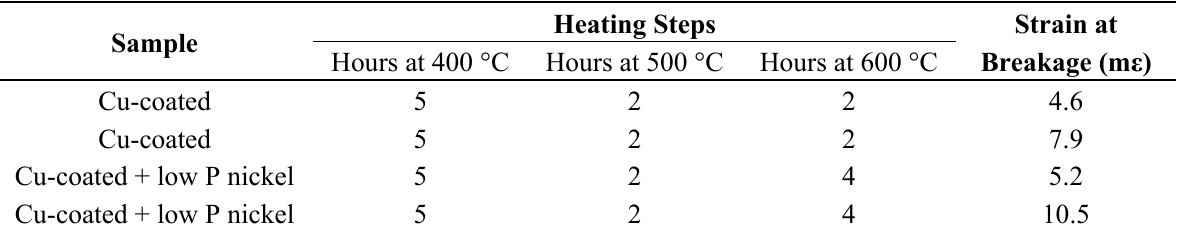
Table 3. Tensile strength of metal-coated fibers after three-step annealing, firstly at 400 °C, then at 500 °C and subsequently at 600